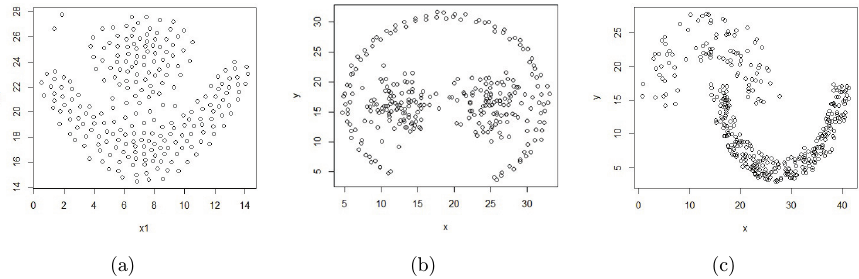
Fig. 2. Structure distributions of shape and synthetic datasets. (a) Flame (b) Pathbased (c) Jain (d) Smiley (e) A1 (f)